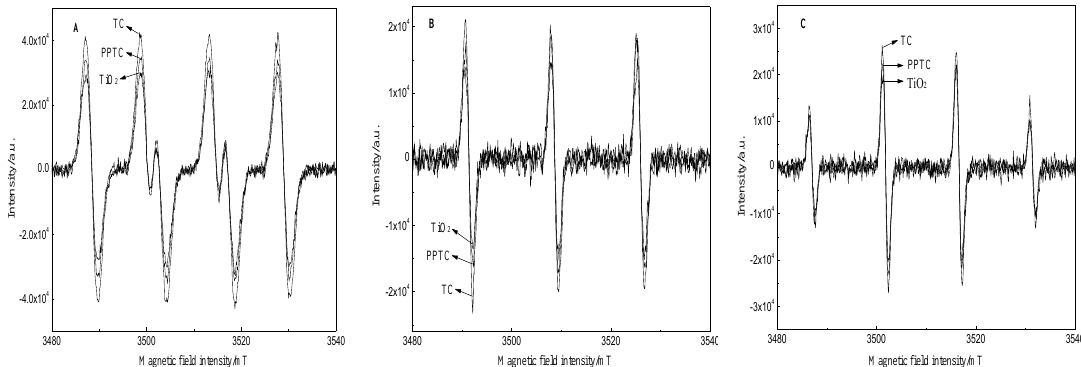
Figure 9. ESR spectra of ( A ) superoxide free radical (O 2· ), ( B ) singlet oxygen ( 1 O 2 ), and ( C ) hydroxyl radical (·OH) in TiO 2 , TC, and PPTC.